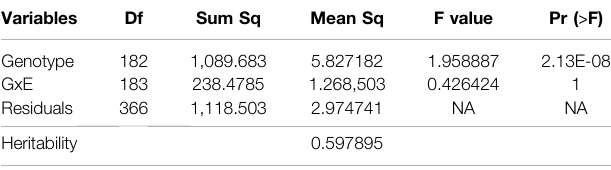
TABLE 1 | Summary of analysis of variance in Turkish common bean